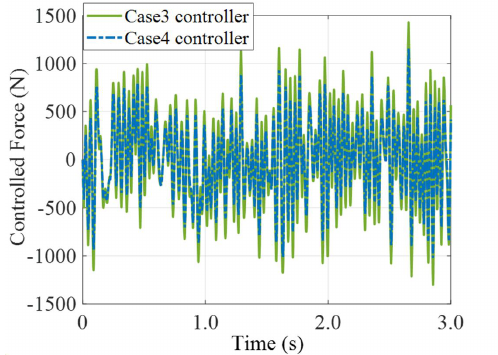
Figure 10. Controller forces in Case 3 and Case